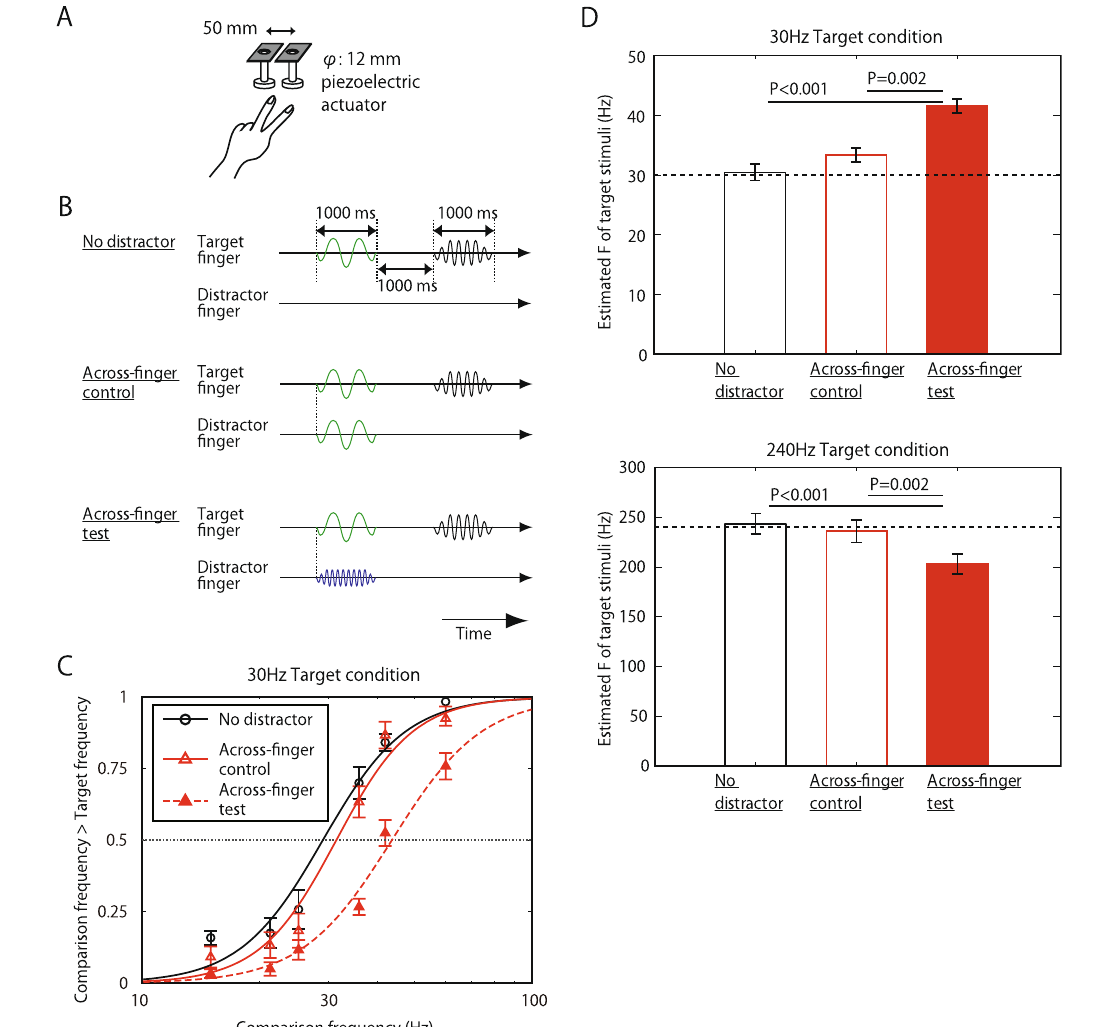
Figure 1. Frequency interaction Across-finger. ( A ) Schematic views of the set up. ( B ) Trial sequences for each distractor conditions, when the target frequency was 30 Hz. When the target frequency was 240 Hz, the green waves representing 30-Hz vibrations and a blue wave representing 240 Hz vibration were interchanged. Participants were asked to make binary response (higher, lower) about the perceived vibration frequency of the second/comparison vibration compared to the first/target vibration on the target finger, and they received a feedback beep after each response. The frequency of the target and distractor vibration was 30 Hz or 240 Hz, while that of comparison was varied. The perceived intensity of all stimuli were kept at the same level. As for the distractor vibration, the same-frequency vibration was presented in the control condition, while the other was presented in the test condition. The onset and duration of target and distractor stimuli were the same. Note that participants were explicitly told which fingers were the target and distractor. The target finger was fixed during a block and counterbalanced across blocks. ( C ) Psychometric functions representing the proportion of trials where participants judged the frequency of the comparison vibration to be higher than that of the target, which was fixed at 30 Hz. Each data point represents the average across ten participants. Error bars indicate ± 1 SEM. ( D ) PSEs of the target vibration of 30 Hz (top) and 240 Hz (bottom) for each distractor condition. N = 10. Error bars indicate ± 1